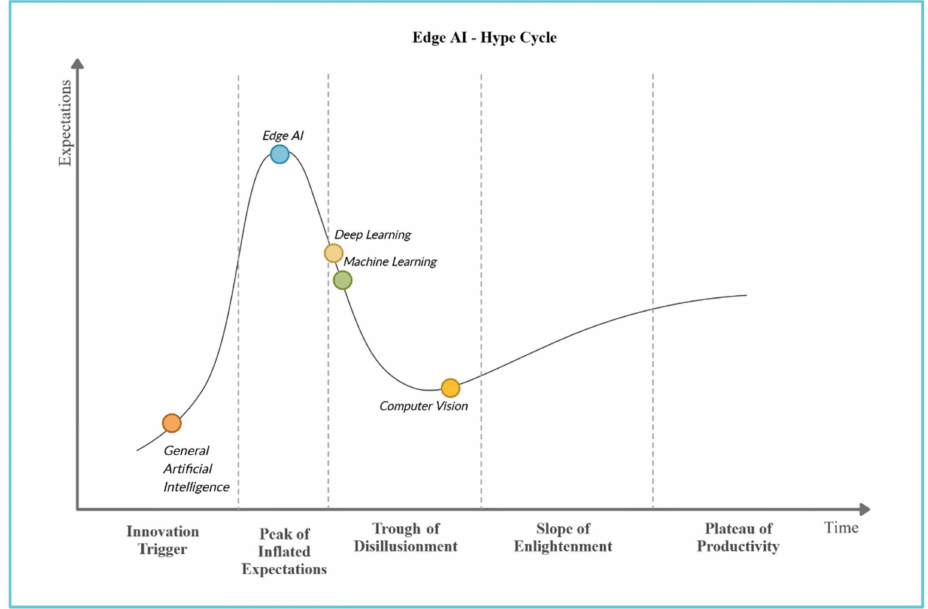
Figure 2. Technology trend cycle